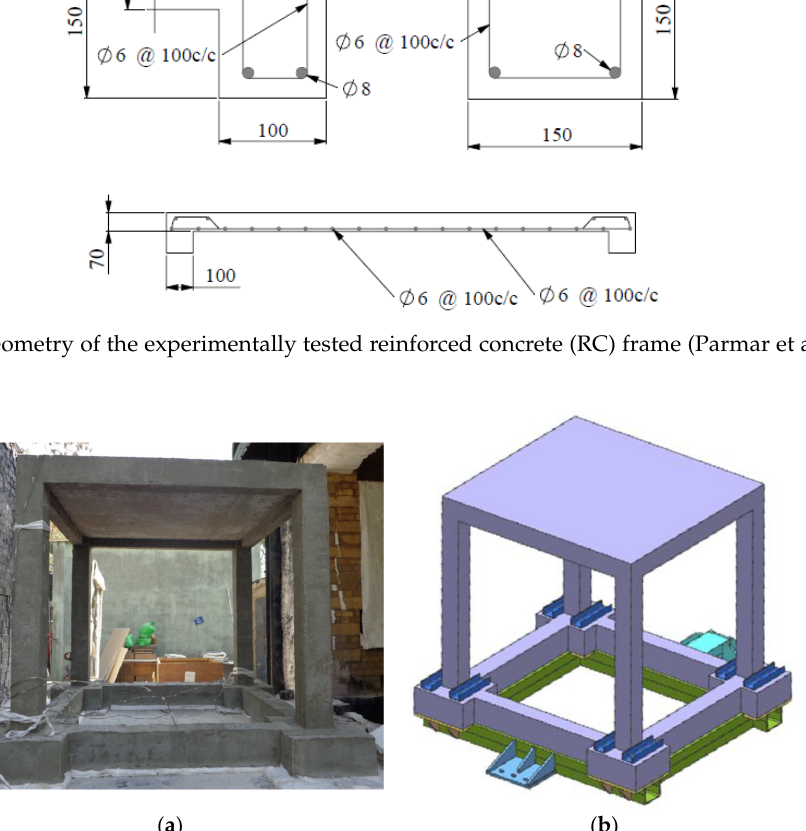
Figure 4. ( a ) RC frame before testing and ( b ) fixing of the base of the frame (Parmar et al. [33]).